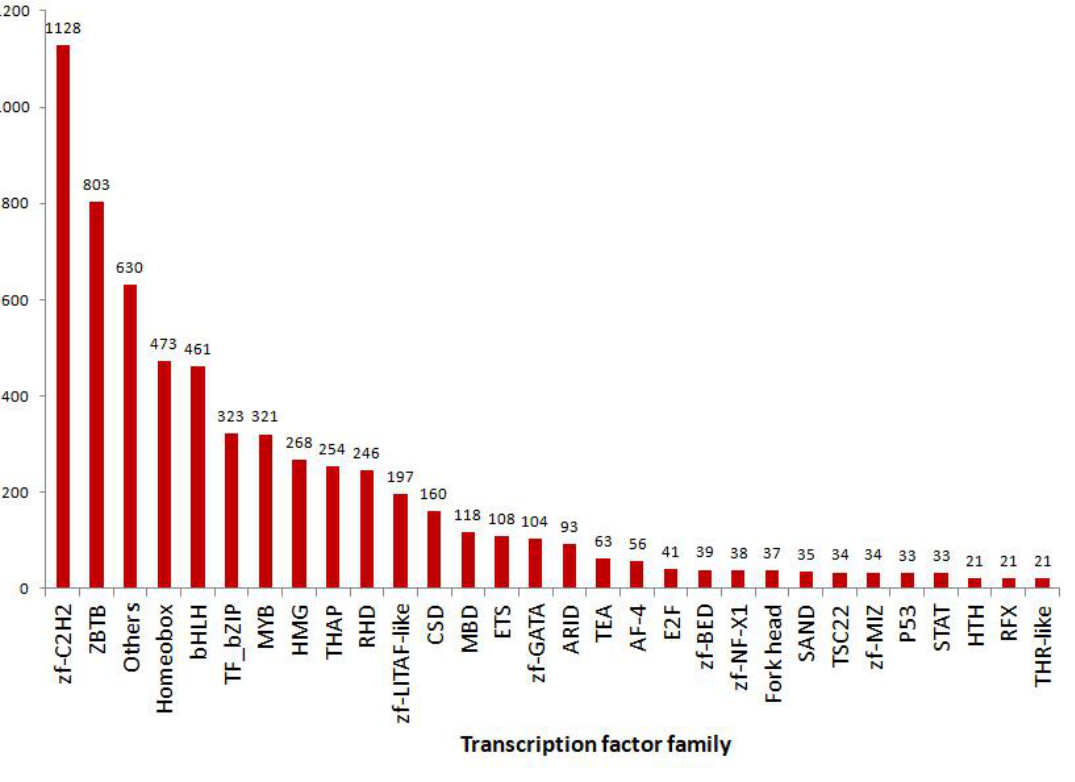
Figure 3. Numbers and families of the top 30 transcription factors in M. rosenbergii predicted by comparison against the AnimalTFDB